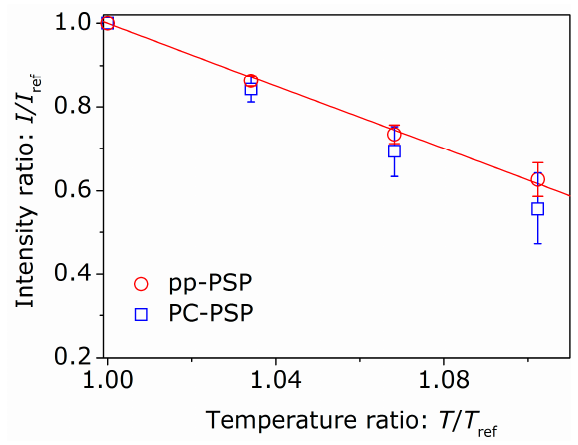
Figure 3. Relation between luminescent intensity and temperature for pp-PSP and PC-PSP, where T ref = 293 K .